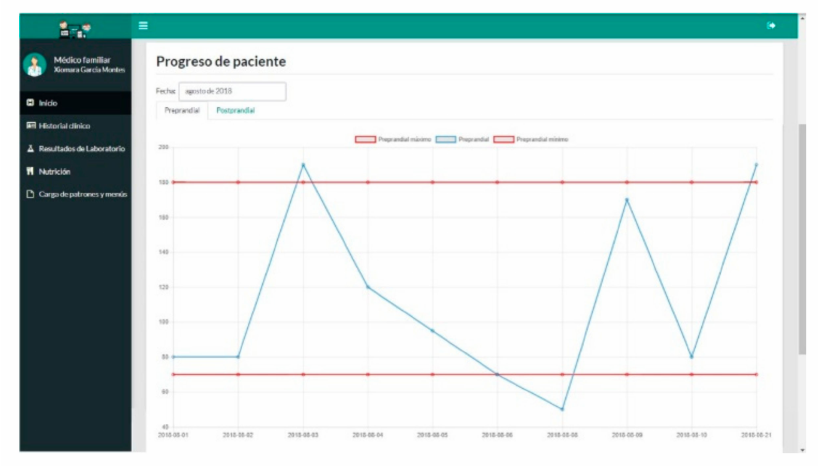
Figure 19. Physician application interface: Graph of the progress of the patient’s glucose levels.